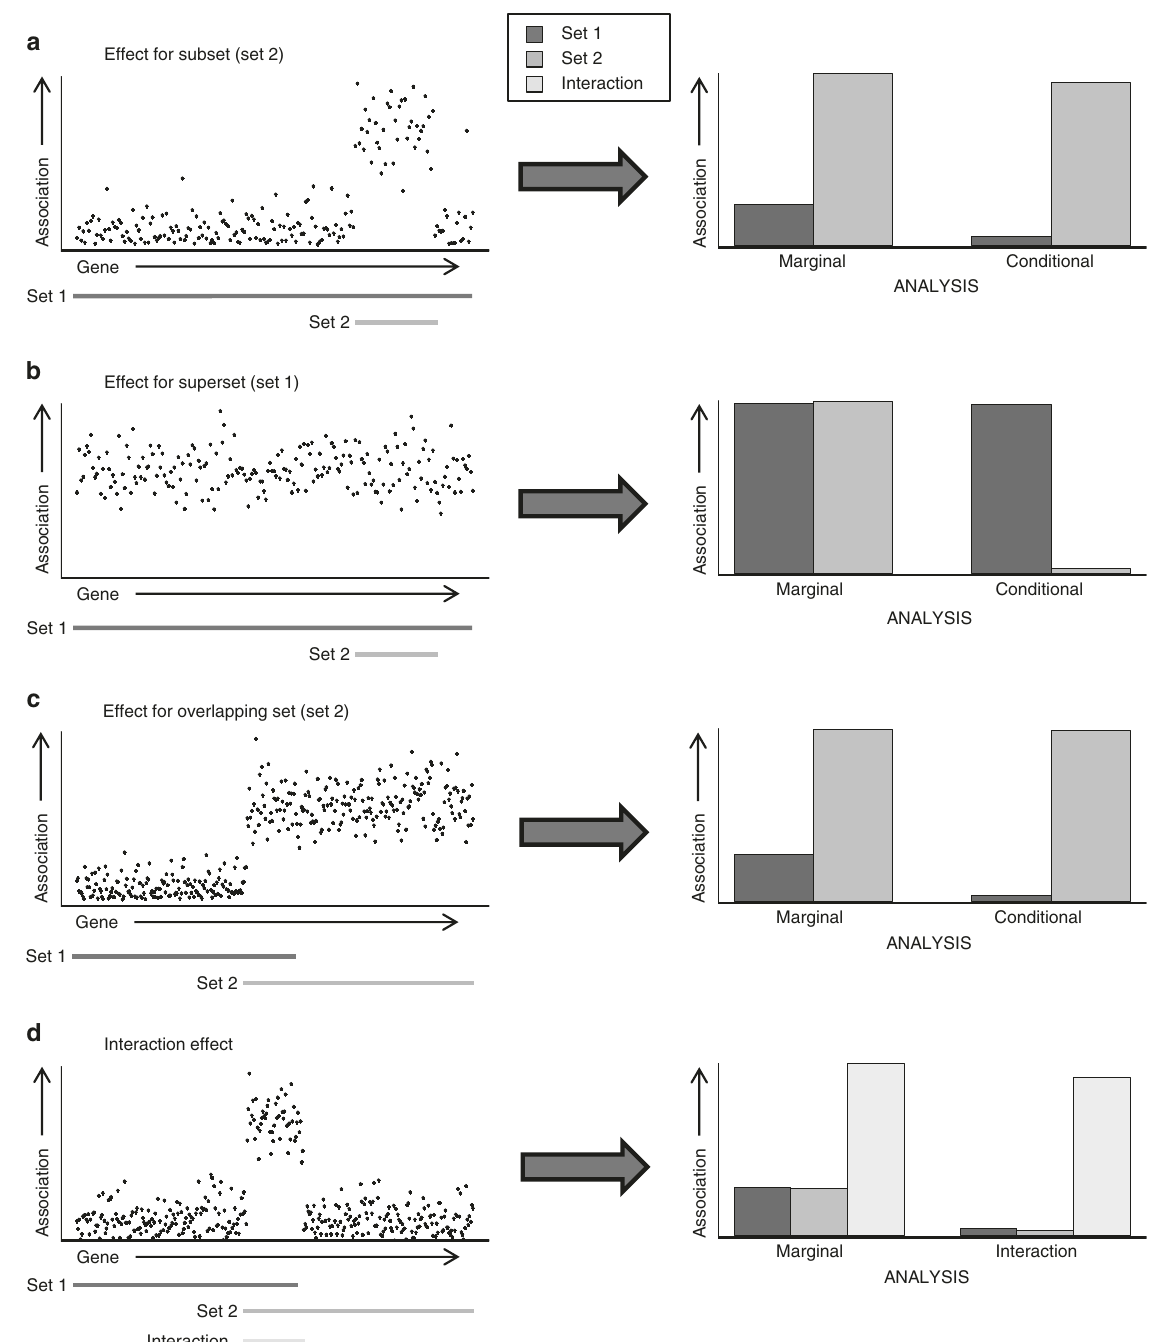
Fig. 1 Illustration of different confounding scenarios. In each of the scenarios, a gene set with no relevance to the phenotype overlaps with a relevant gene set, resulting in a confounded association. The left column contains scatterplots of gene associations as a function of their position, with the lines below the plots indicating which gene sets they belong to. The right column contains bar plots showing the resulting gene-set associations, when analysing either the marginal associations of each gene set individually (as in traditional GSA) or when using a joint conditional ( a – c ) or interaction ( d ) analysis of the two gene sets. In a – c , one of the gene sets is relevant to the phenotype, with the other having no effect; in d the effect is assigned to the interaction between the two sets, with neither having a main effect. In all scenarios this is shown to be correctly re fl ected by the conditional/interaction analysis, but not the marginal